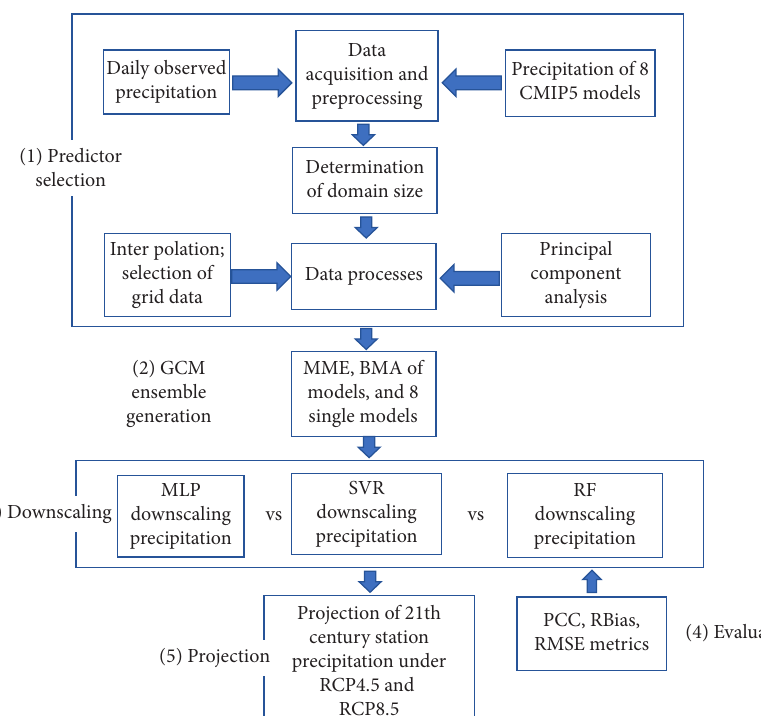
Figure 3: The framework of this